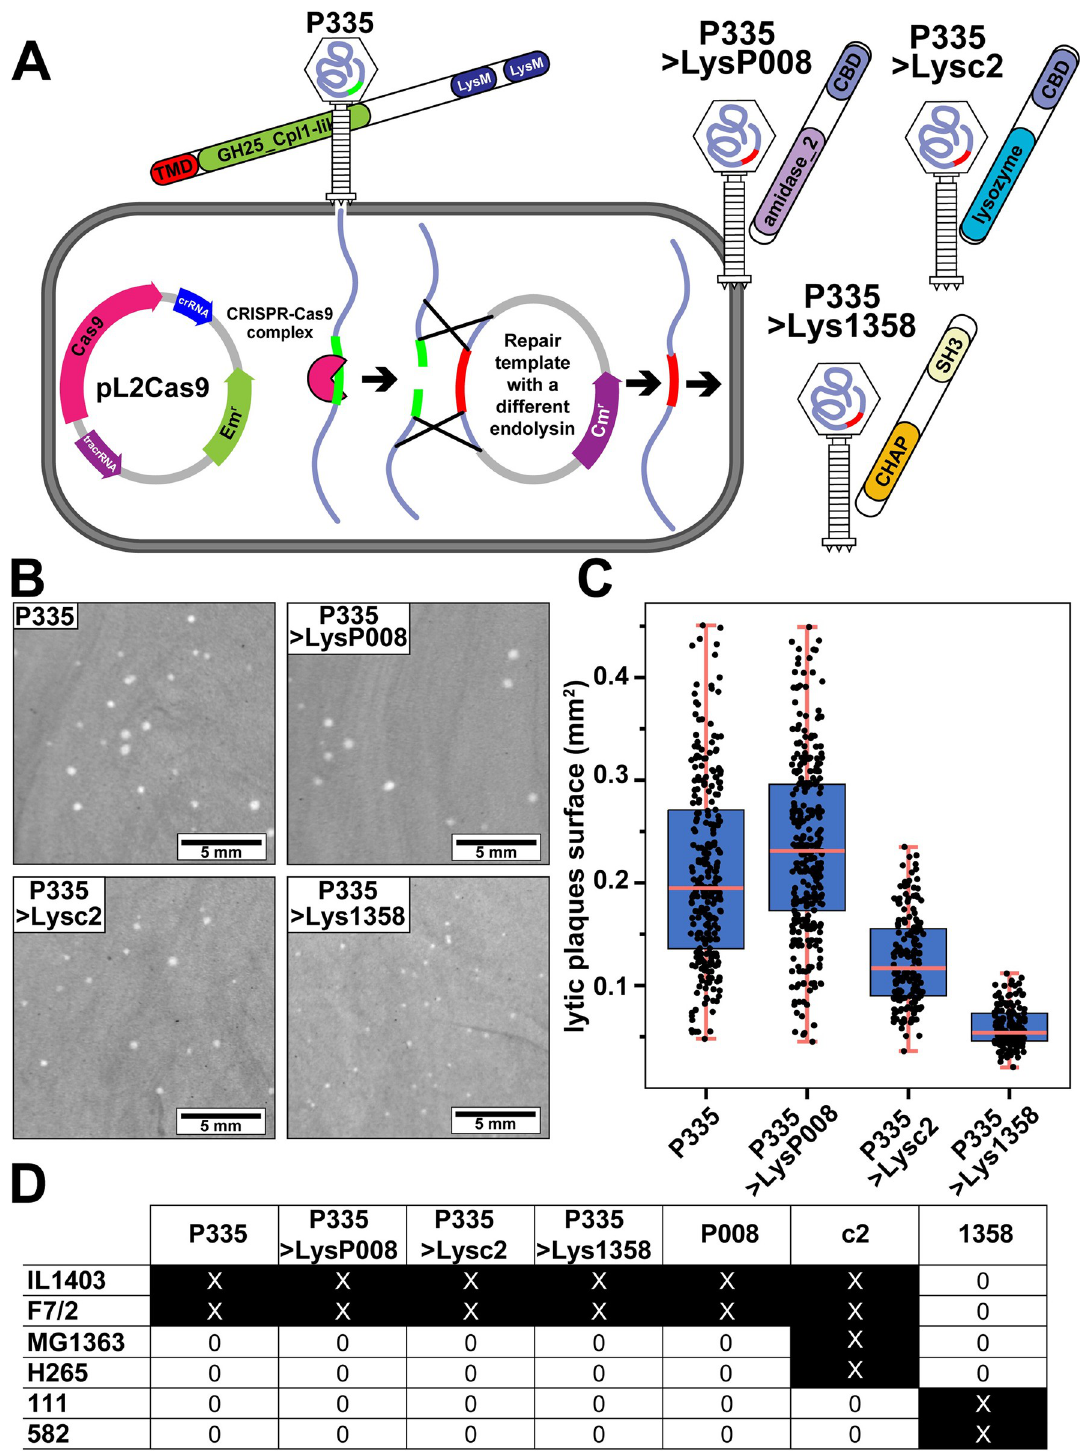
Fig 3. The gene coding for the endolysin in the virulent phage P335 was swapped by genome editing with homologs from other lactococcal phages. ( A) Graphical representation of the genome editing of virulent phage P335 using CRISPR-Cas9. The gene coding for the endolysin of phage P335 was swapped with those from L . lactis -infecting phages P008, c2, and 1358. L . lactis strain IL1403 was transformed with 2 plasmids: (1) pL2Cas9-LysM1, to cleave the P335 genomic DNA within the endolysin gene; and (2) a second plasmid containing a repair template containing the gene to be exchanged. The endolysin gene in the repair template is flanked by 2